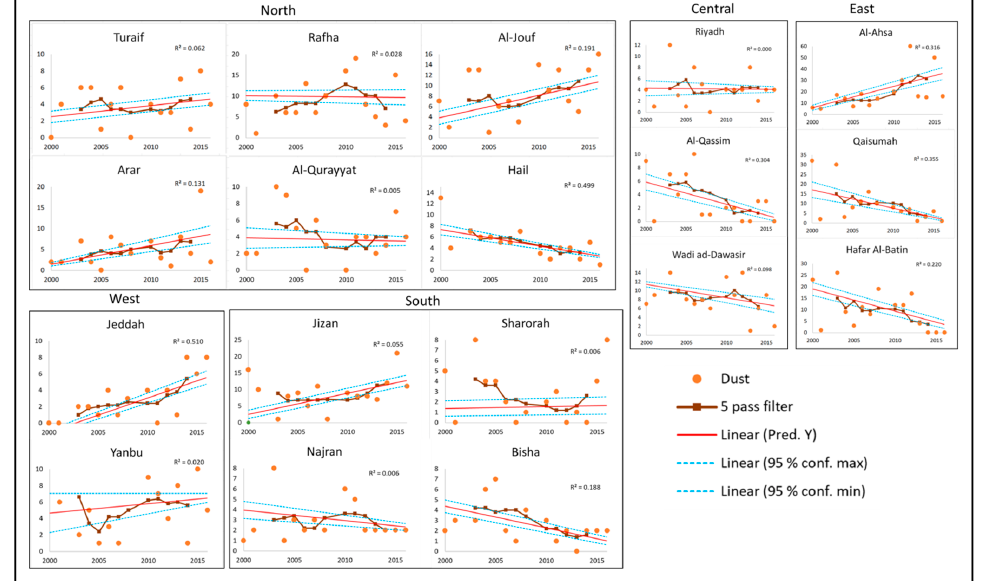
Figure 4. Scatter plots showing the total annual number of dust storm events per Presidency of Meteorology and Environment (PME) station between the years 2000 and 2016, including a five-pass filter and linear regression line with associated model error bounds (at 95% confidence interval).